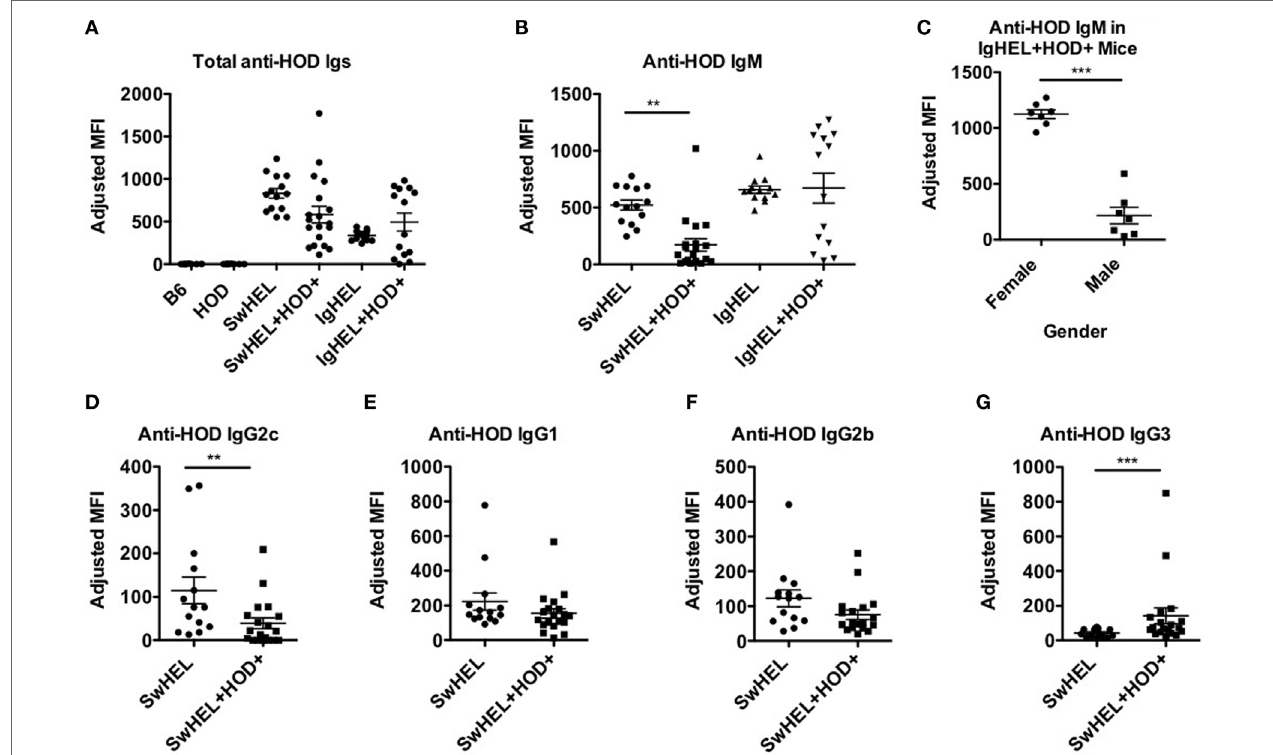
FigUre 4 | Autoantibodies are detected in SwHEL + HOD + and IgHEL + HOD + mice. To evaluate whether B cells that escaped central and peripheral tolerance secreted autoantibodies, sera was collected from experimental mice and assayed for anti-HOD antibodies. (a) Total anti-HOD immunoglobulins (Igs) was determined by flow crossmatch against HOD and control B6 red blood cell targets. Anti-HOD IgM antibodies were evaluated in (B) BCR-Tg mice and (c) the role of gender in autoantibody production was assessed in IgHEL + HOD + mice. Production of (D) IgG2c, (e) IgG1, (F) IgG2b, and (g) IgG3 subtype-specific antibodies were evaluated in SwHEL and SwHEL + HOD + mice. Scatter dot plots shown are compiled from three independent experiments with at least three mice per group. Selective p values are shown on graphs and * ≤ 0.05, ** ≤ 0.01, and *** ≤ 0.001. For complete statistical analysis with all significant differences, see Table S4 in Supplementary